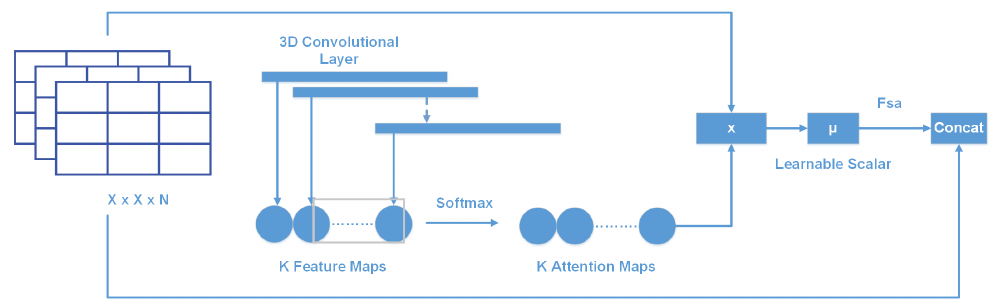
Figure 6. Soft-Attention layer.